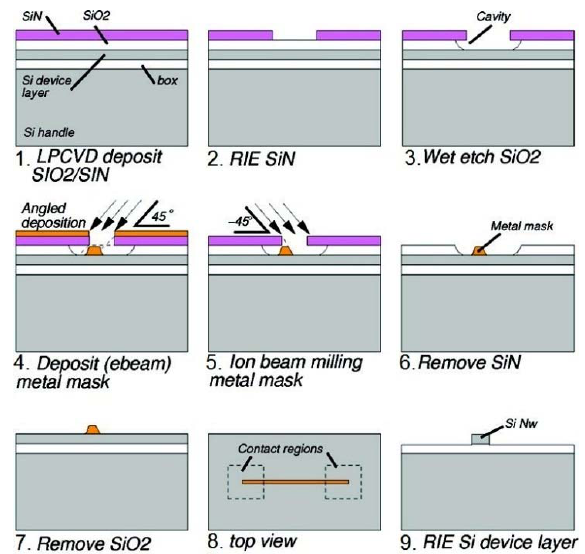
Figure 4. Schematic illustration of SiNW fabrication by the edge ‐ transfer technique: ( 1 – 3 ) patterning of the nano ‐ cavity by selective wet ‐ etching of SiO 2 supporting structures with Si 3 N 4 mask; ( 4 – 6 ) forming the Cr mask by Ar milling under angle and wet ‐ etching of the supporting structures; and ( 7 – 9